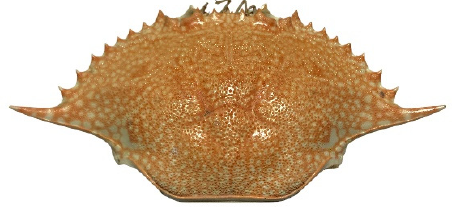
Figure 4. The dried crab-shell as calcium precursor.